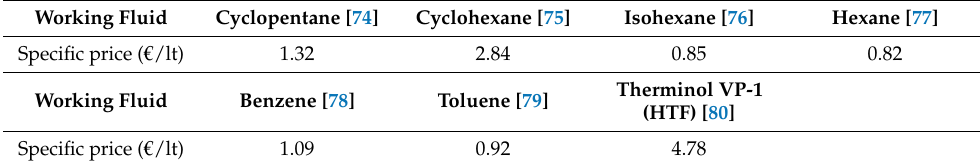
Table 8. Specific cost of working fluids and heat transfer fluid Therminol VP-1 (in € 2020). Working